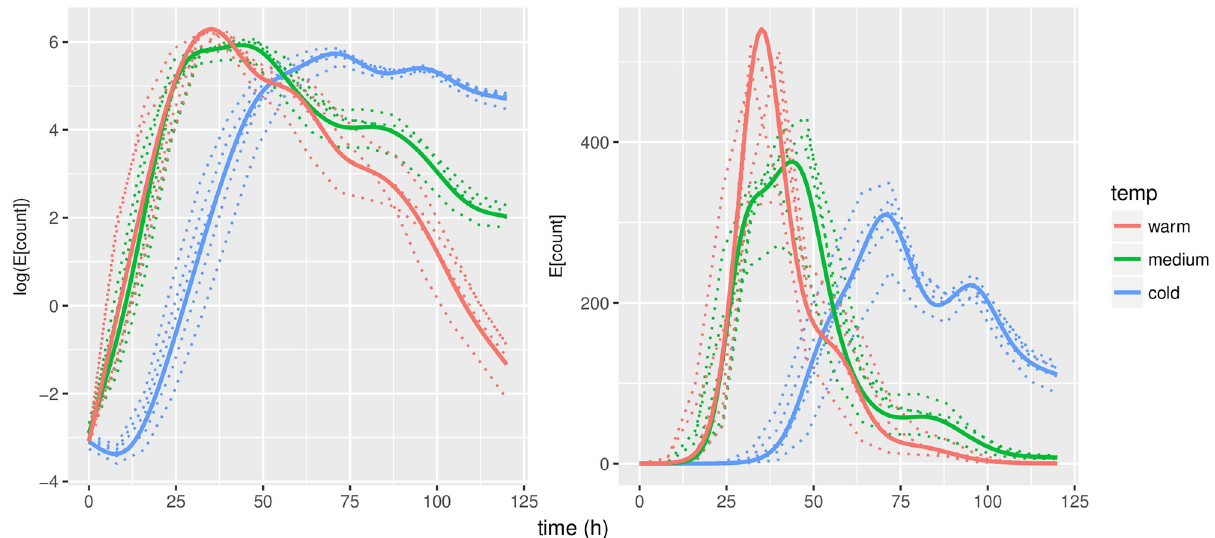
Fig 4. Predicted trajectories for u (dashed lines). Left is on model scale, right is exp-transformed (same scale as the observations). Thick lines indicate estimated population means.